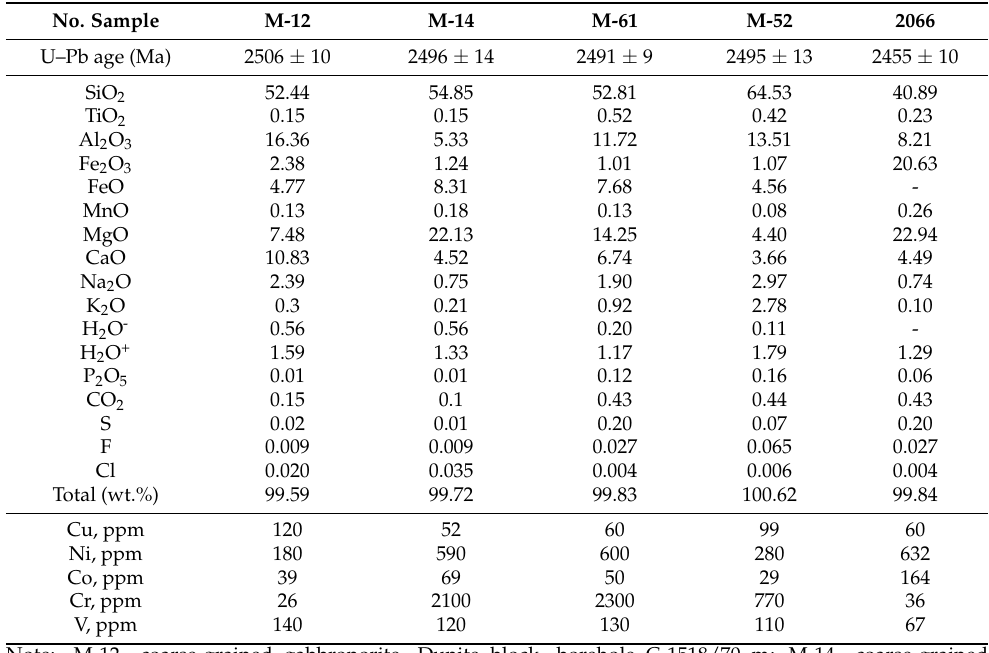
Table 1. The content of oxides and ore elements in the dyke rocks according to atomic absorption analysis and the U–Pb age